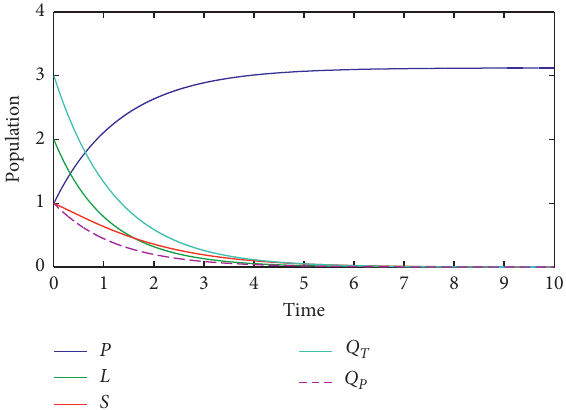
Figure 2: The evolution of the population when R